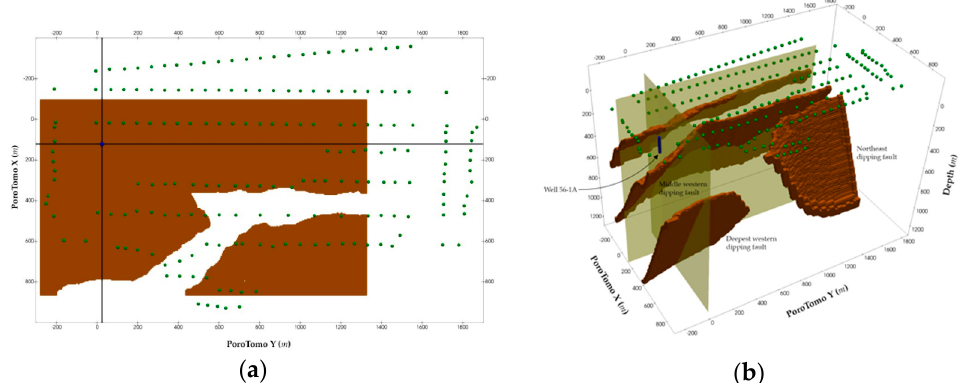
Figure 2. ( a ) Map view of survey: Well 56-1A in blue near PoroTomo origin (location of vertical distributed acoustic sensing (DAS)) and surface sources shown in green dots. ( b ) Southern view of 3D rendering of four faults model [10]. The three faults successfully imaged are labeled middle & deepest Western dipping fault on the left, and the Northeast dipping fault on the right.